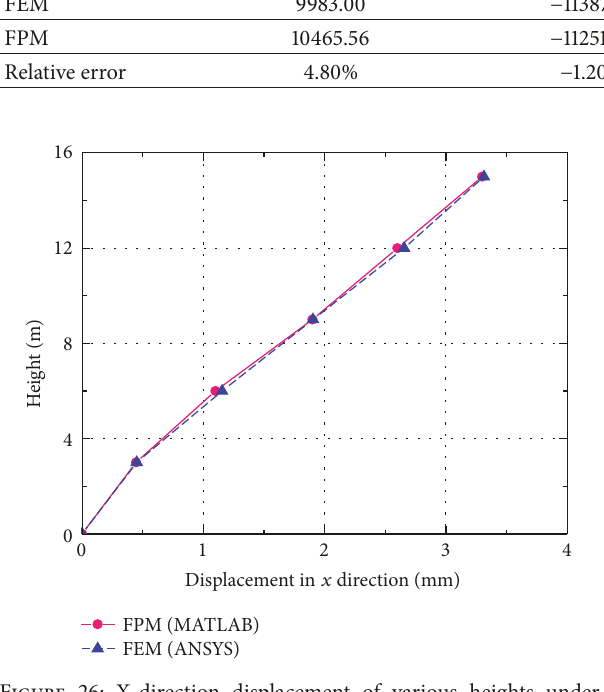
The shear time history curve for the left end of element 22 is shown in Figure 29.